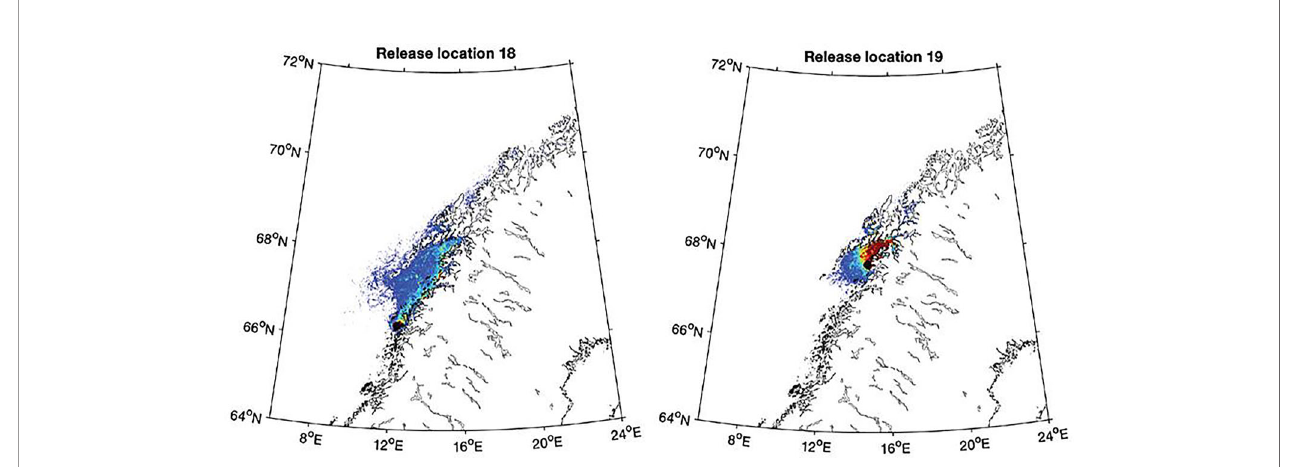
FIGURE 7 | Aggregated particle concentration from release locations south of the Lofoten archipelago area, release locations indicated (locations no 18-19 in Figure 5 ). Dark blue colour represents low aggregation and red colour high